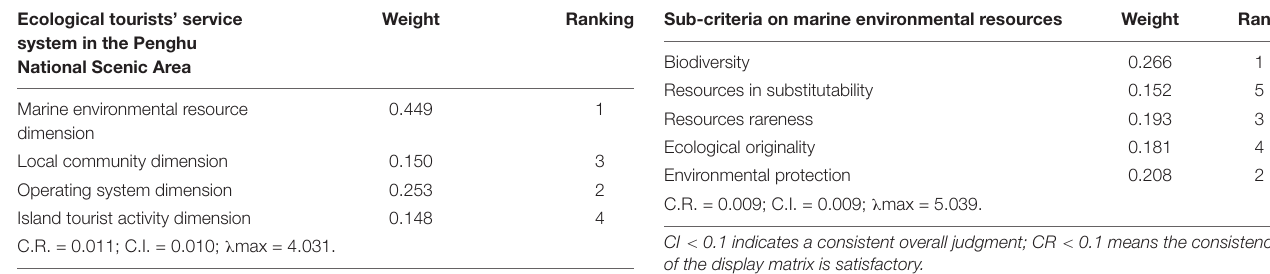
TABLE 3 | Analysis of the relative critical dimensions in the main dimension. TABLE 5 | Key indicators of marine environmental